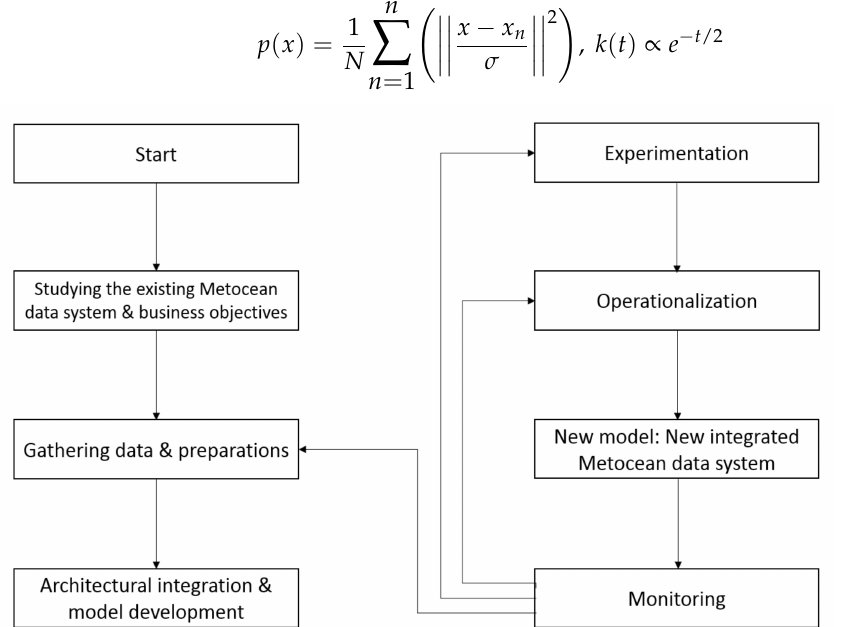
Figure 4. Proposed research